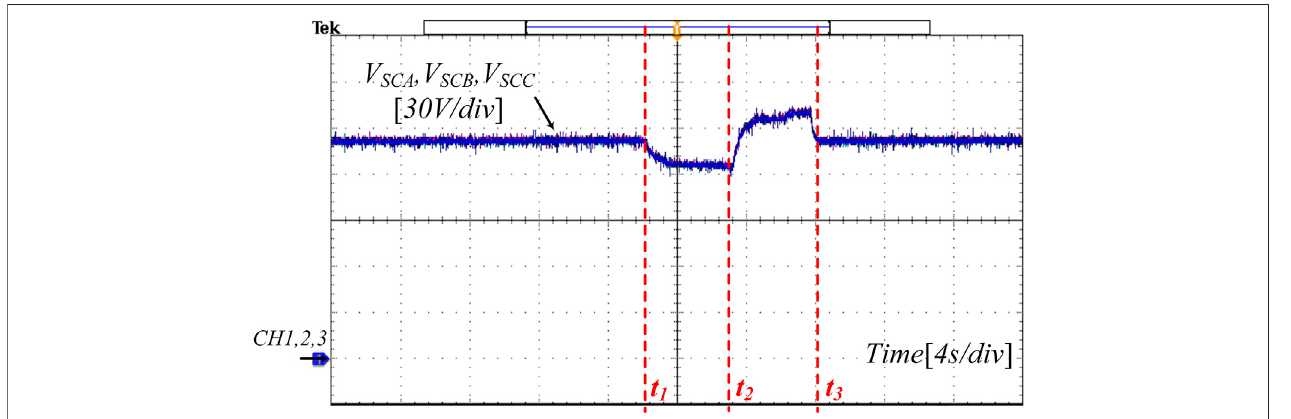
FIGURE 14 | Waveforms of SC voltages during the whole experiment